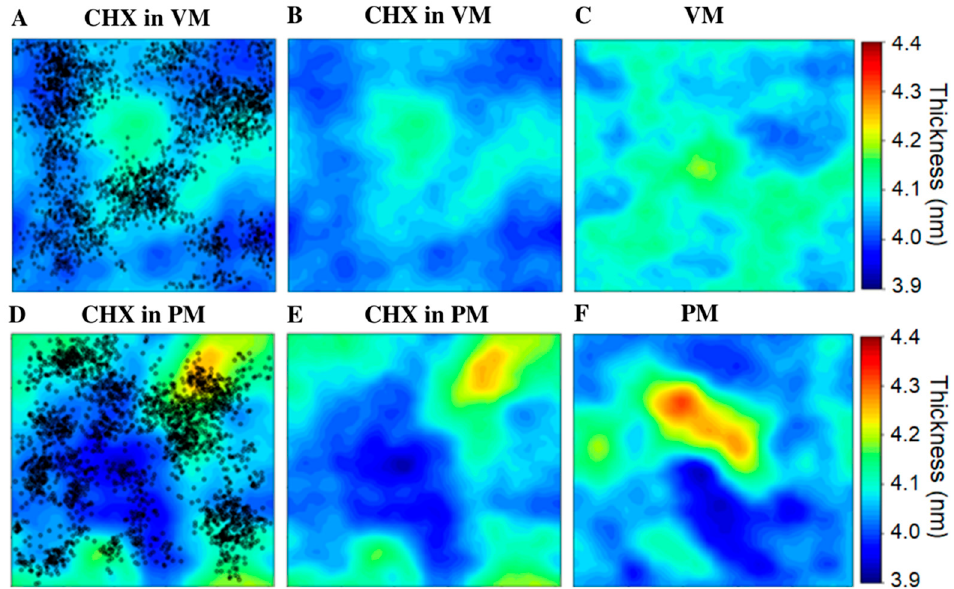
Figure 5. ( A , D ) Bilayer thickness of CHX-membrane systems projected on the membrane plane; upper and lower panels correspond to VM and PM, respectively. The X-Y positions of CHX molecules are shown as black dots. In ( B , E ), CHX are removed for clarity. ( C , F ) Thickness maps of membrane only systems, without CHX.3.5. Effect of CHX on Pore Formation.